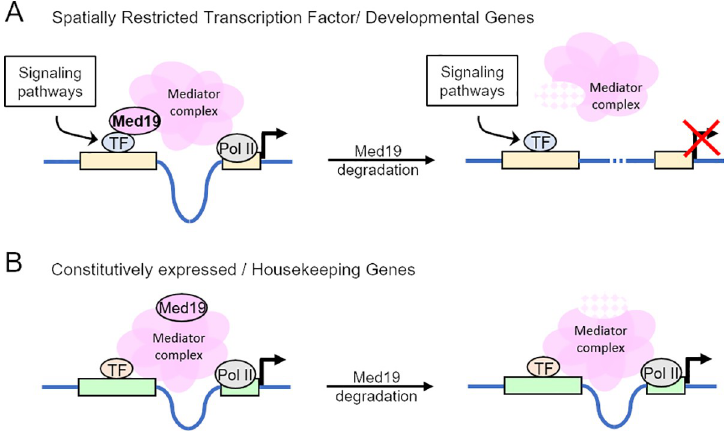
Fig 6. Model, derived from the analysis of the nature of the genes deregulated or not after Med19 AID degradation, showing how Med19 may function. (A) Med19 acts as a critical cofactor of transcription factors whose activity is regulated by signaling pathways, in negative or positive control of transcription. (B) Med19 is not a Mediator subunit required for the expression of the constitutively expressed genes.